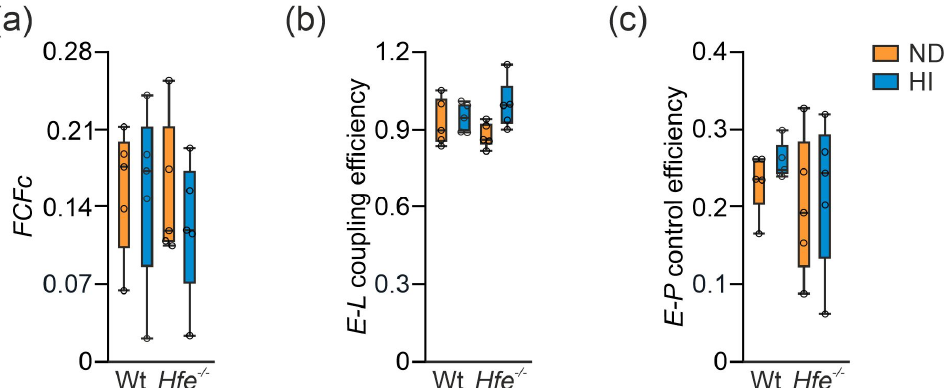
Figure 5. Impact of dietary and genetic iron overload on flux control factors. ( a ) Cytochrome c control factor ( FCFc = 1-PM P /PM cP ) indicates integrity of the mitochondrial outer membrane. ( b ) E-L coupling efficiency ( j E-L = 1-PM L /PM E ) indicates preserved coupling of electron transfer to phosphorylation of ADP. ( c ) E-P control efficiency (1-PM cP /PM E ) indicates the limitation of OXPHOS capacity by the capacity of the phosphorylation system. n = 5 mice per group. Two-way ANOVA: ( a ) diet, F (1,16) = 0.2989, p = 0.5921; genotype, F (1,16) = 0.3760, p = 0.5484; diet X genotype, F (1,16) =